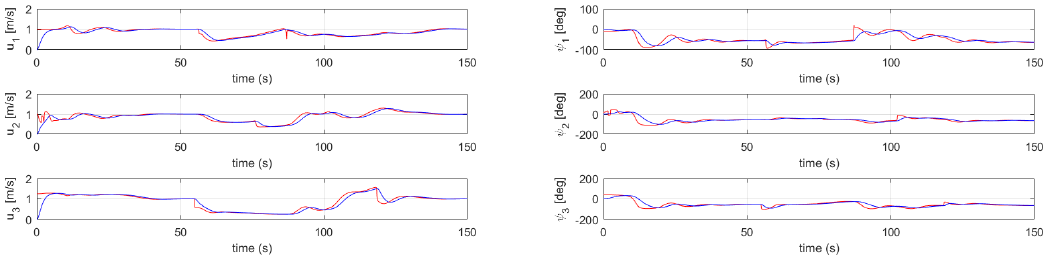
Figure 14. USV speed and heading profiles during swarm aggregation combined with path-following guidance for three